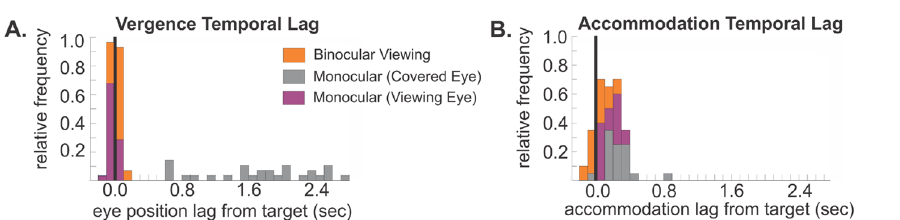
Figure 4. Vergence and accommodation temporal lag. (A) Stacked frequency distribution of the timing difference between vergence and target. (B) Stacked frequency distribution of the timing difference between accommodation and target. Black vertical line indicates zero temporal